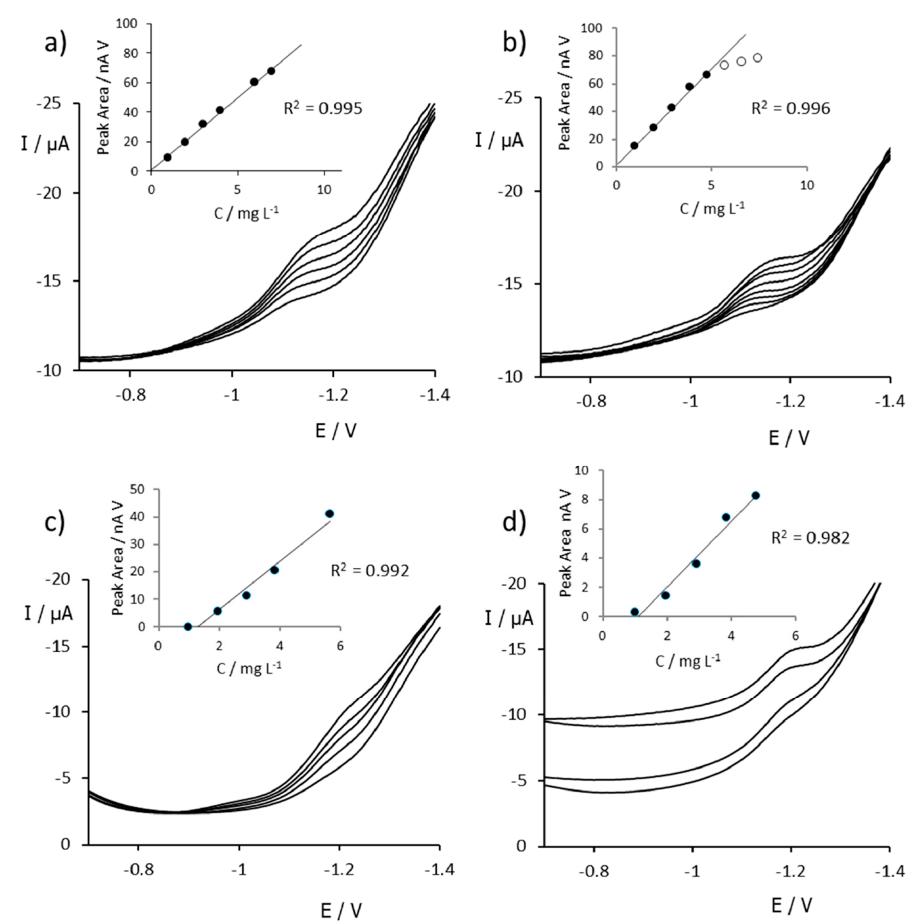
Figure 5. DPV voltammograms measured at pH 2.2 using an SPCNFE in BZT ( a ) and Me-BZT ( b ) solutions and using an SPCNTE in BZT ( c ) and Me-BZT ( d ) solutions. The insets show the corresponding calibration plots estimated using the peak areas and the R 2 values